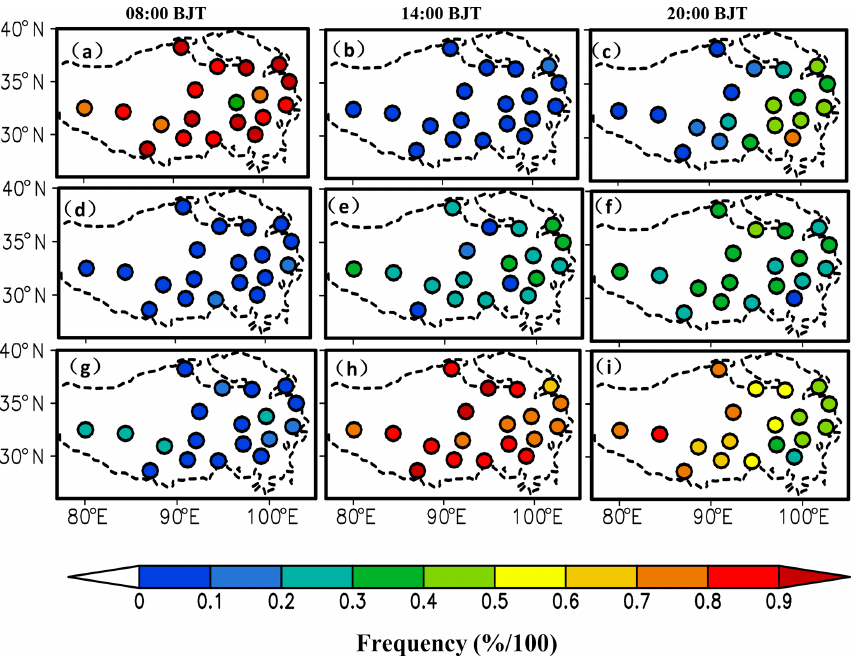
Figure 5. Spatial distribution of the occurrence frequency for the SBL (a–c) , NBL (d–f) , and CBL (g–i) at 08:00, 14:00, and 20:00BJT.